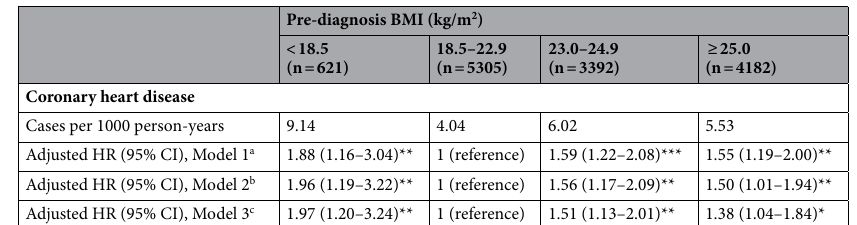
Table 1. Baseline characteristics of cancer survivors at enrollment according to body mass index (BMI) categories in the National Health Insurance-Health Screening cohort (NHIS-HEALS) database. Data above are presented in n(%) unless otherwise stated. Q quartile, sd standard deviation, ESC European Society of Cardiology, SCORE systematic coronary risk evaluation, CVD cardiovascular disease, NSAIDs non-steroidal anti-inflammatory drugs, ANOVA analysis of variance. a Proxy for income status (does not necessary represent the exact economic status). b Based on the ESC SCORE chart for low risk countries. c Family history of heart disease or stroke, based on a self-reported questionnaire. d Based on the outpatient visit or hospital admission records with claims code for major depressive disorder/major depressive disorder, recurrent (ICD-10 codes: F32 and F33). e Based on the prescription data for the patients in the NHIS-HealS database. f Excludes thyroid cancer and other first site cancers listed in the cateogry. g p -value from chi-square test for categorical variables and ANOVA for continuous variables for BMI groups.